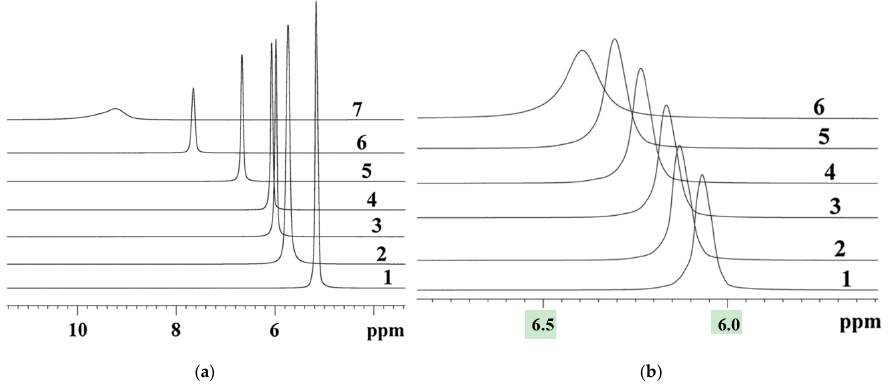
Figure 7. ( a ) The 1 H NMR spectra of the acid ionic form of the Nafion 117 membrane at different humidities: (1) RH = 95%; (2) RH = 78%; (3) RH = 64%; (4) RH = 58%; (5) RH = 32%; (6) RH = 10%; (7) RH = 0. ( b ) The 1 H NMR spectra of the acid ionic form of Nafion membranes at different temperatures: (1) +25 ◦ C; (2) +10 ◦ C; (3) 0 ◦ C; (4) − 20 ◦ C; (5) − 40 ◦ C; (6) − 60 ◦ C. Membrane samples were equilibrated with water vapor at 58% relative humidity. Reprinted with permission from Ref. [41]. Copyright © 2022 Springer-Verlag GmbH Austria, part of Springer